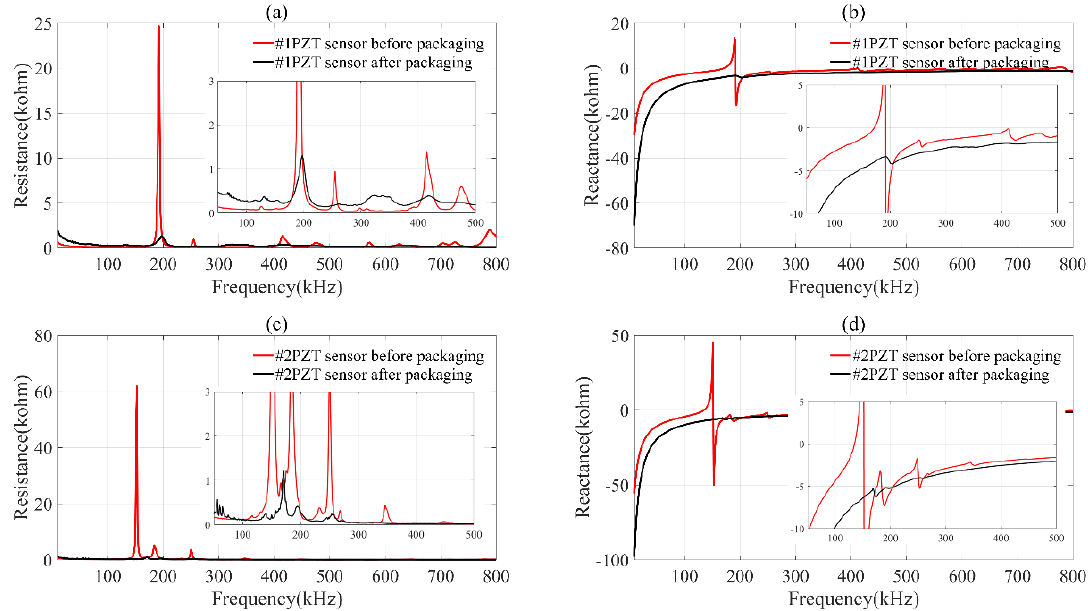
Figure 4. The resistance and reactance spectra of PZT transducers before and after packaging. ( a ) resistance spectra of 1#PZT sensor before and after packaging; ( b ) reactance spectra of 1#PZT sensor before and after packaging; ( c ) resistance spectra of 2#PZT sensor before and after packaging; ( d ) reactance spectra of 2#PZT sensor before and after packaging.